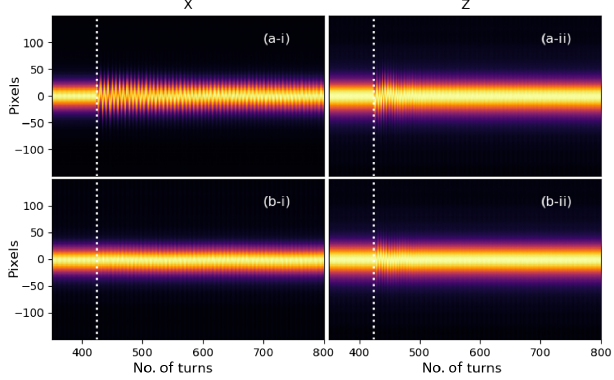
FIG. 14. Typical turn-by-turn imaging of the stored beam with the KALYPSO camera. The vertical white dotted line identifies the trigger of the injection devices and the beginning of the residual oscillations. (a-i) and (a-ii) are related to the kickers in the horizontal and vertical planes, respectively. (b-i) and (b-ii) are related to the MIK in the horizontal and vertical planes, respectively. The active correction is